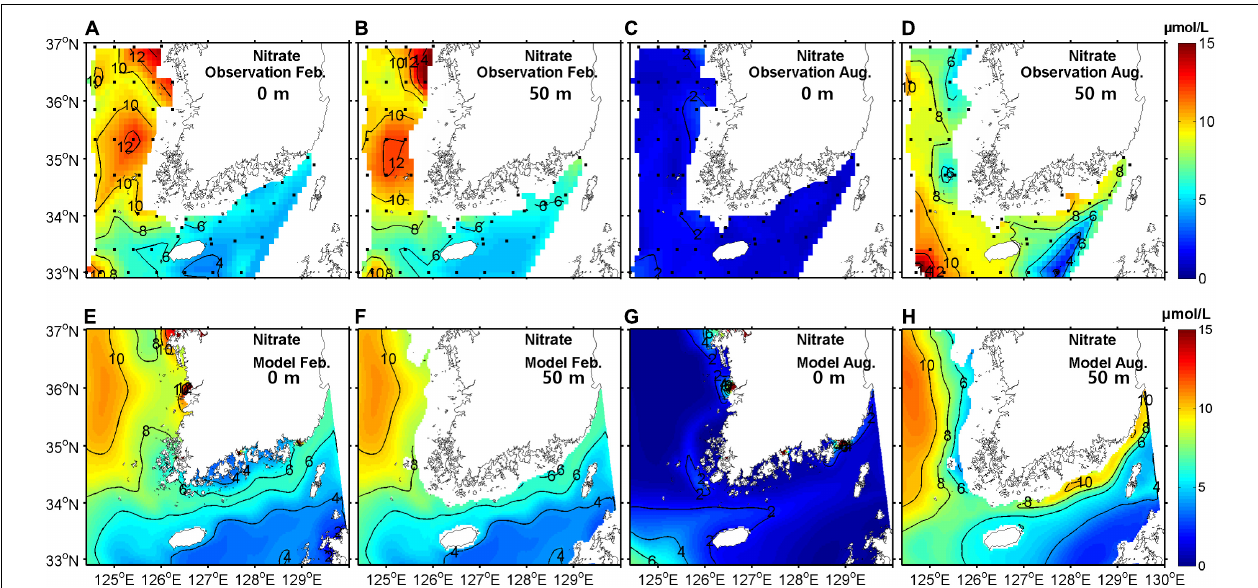
FIGURE 6 | Horizontal distribution of NO 3 − concentrations from observations (upper) and model outputs (lower) at the surface (A,C,E,G) and at a depth of 50 m (B,D,F,H) in February (A,B,E,F) and August (C,D,G,H) averaged for the period 2006–2019 (units are µ mol L − 1 ).